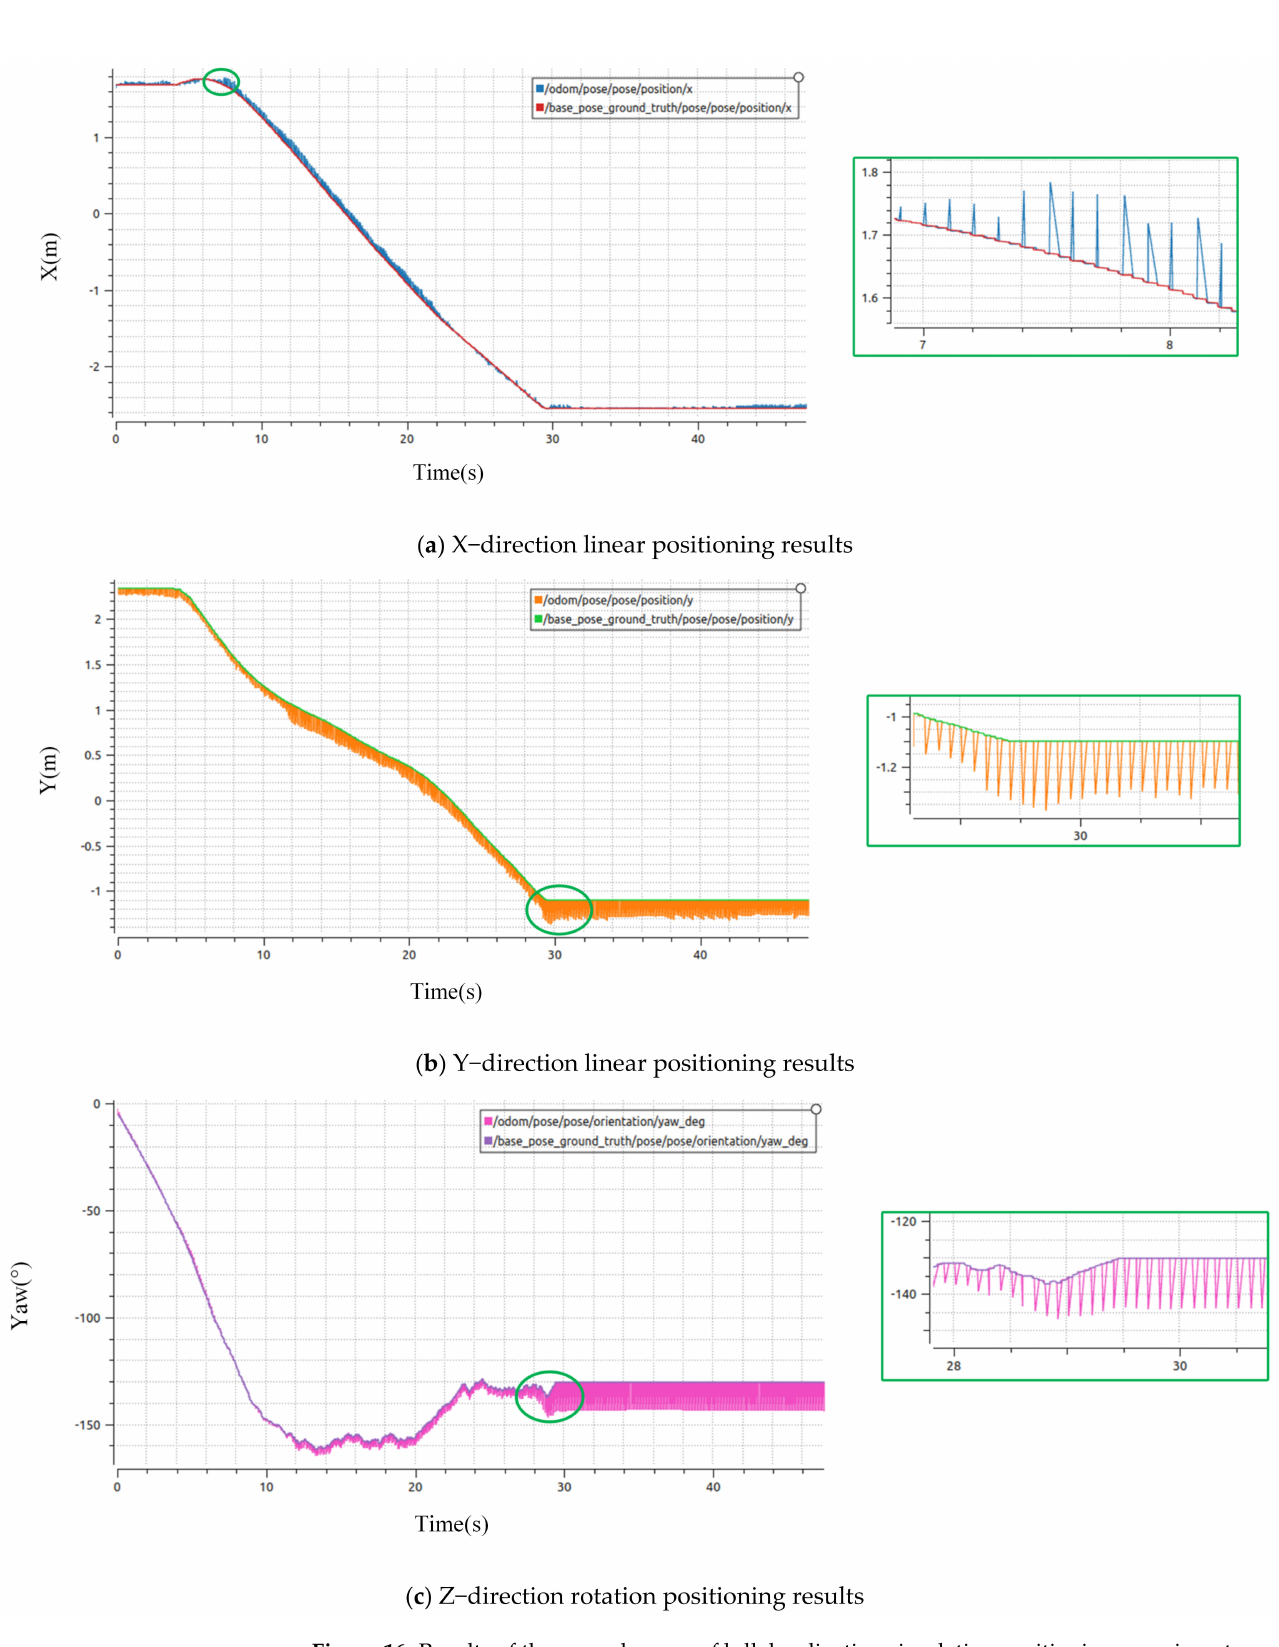
Figure 16. Results of the second group of hdl_localization simulation positioning